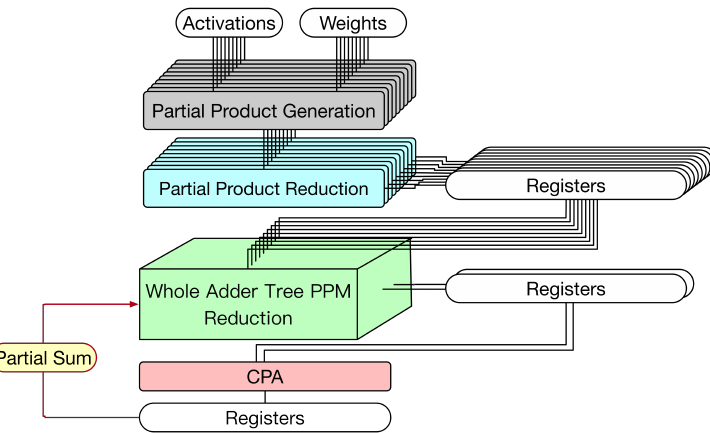
Figure 18. The proposed CA for output stationary dataflow.